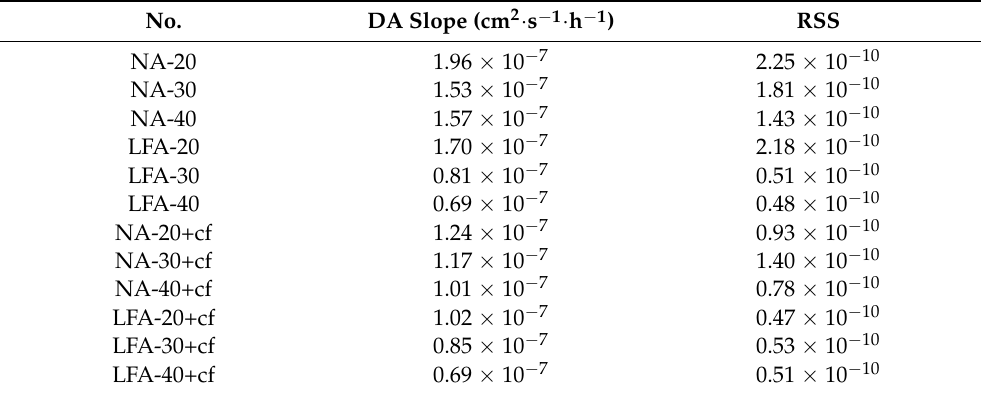
Table 5. The average growth rate of the equivalent diffusion coefficient and the fitted RSS of different anode samples.